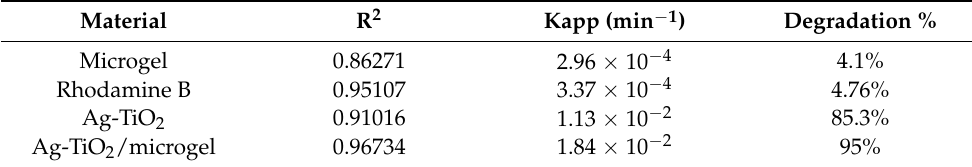
Table 1. R 2 —linear correlation coefficients; k app —photocatalytic degradation rate constant, for the produced materials and pure rhodamine B solution.